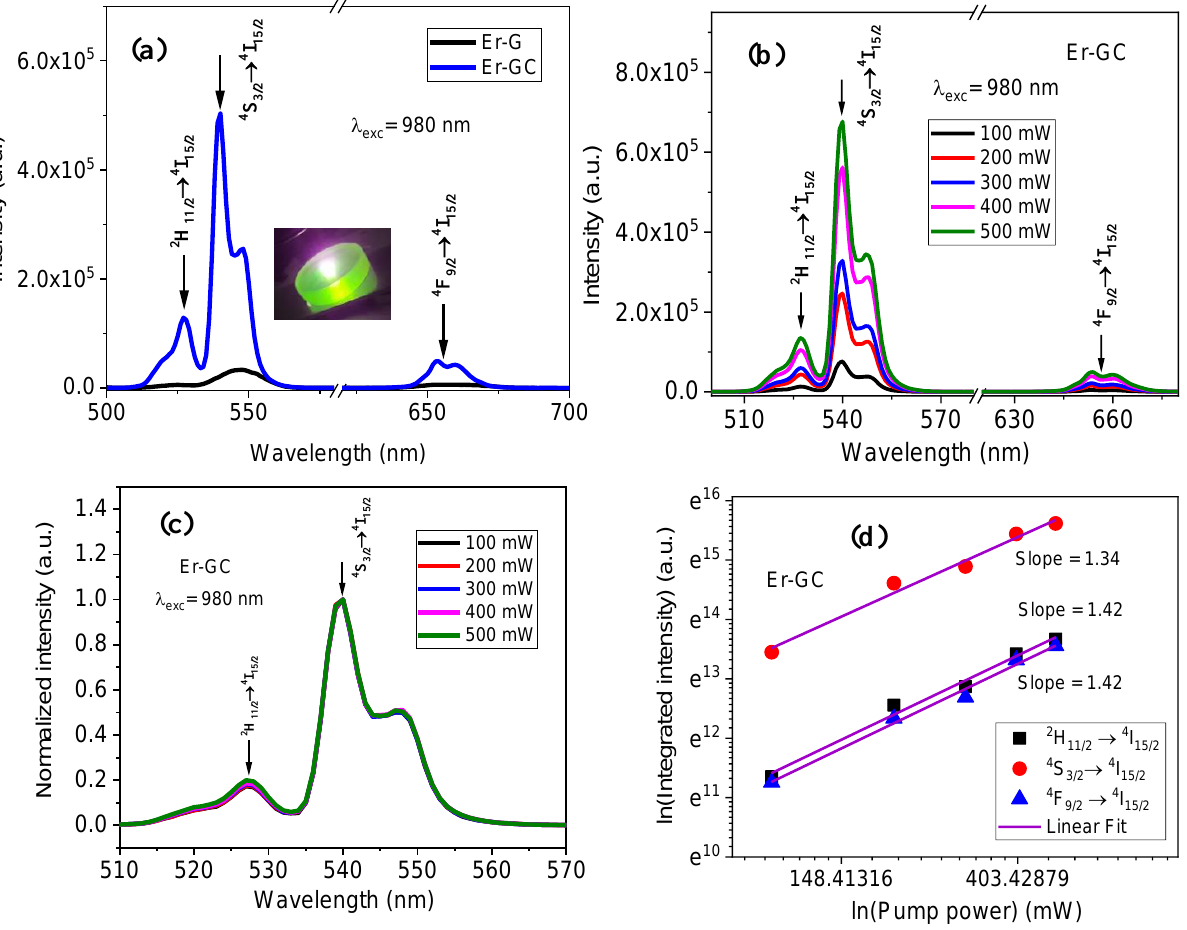
Figure 8. Up-conversion (UC) PL spectra ( a ) at 500 mW pump power for Er-G and Er-GC, and inset is picture of Er-GC exited with laser at 980 nm ( b ) at different pump power for Er-GC, ( c ) normalized at different pump power for Er-GC, ( d ) ln (UC intensity) vs ln (pump power) for Er-GC measured under 980 nm excitation wavelength.